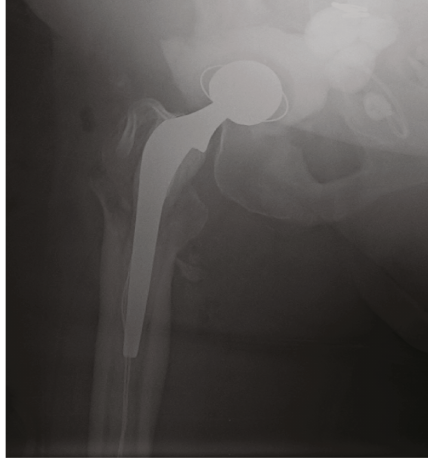
Figure 4: Stage 1: postoperative XR right hip.